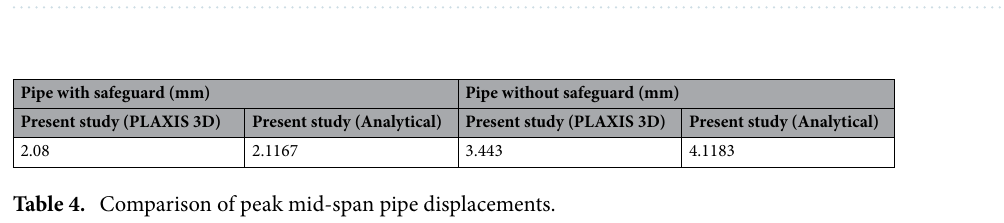
Table 3. Values of input parameters used in the validation and parametric study.